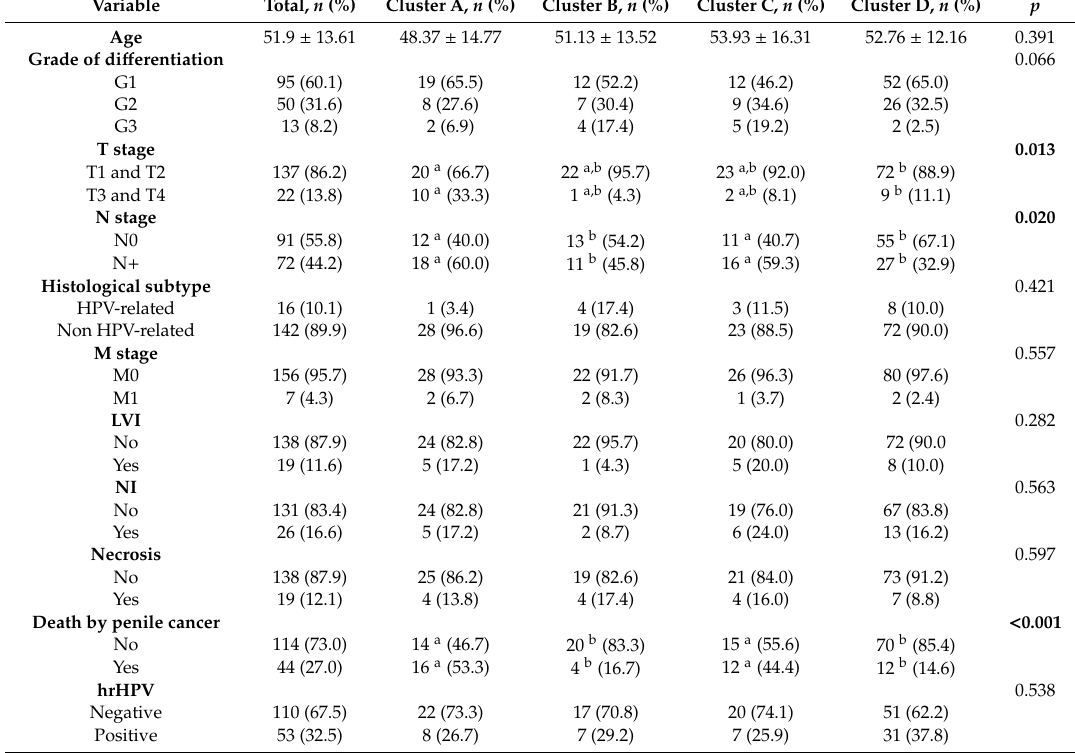
Table 3. Clinicopathological characteristics associated with immune clusters.